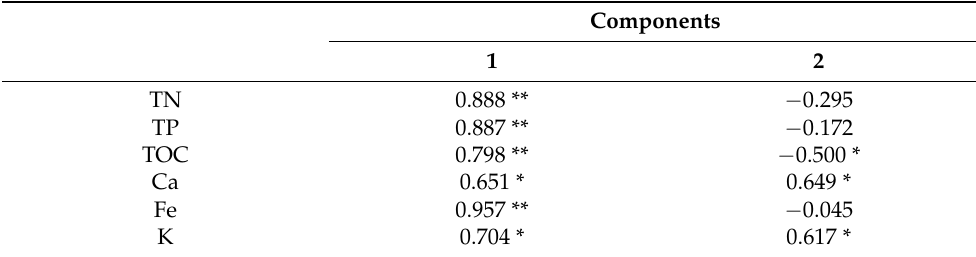
Table 8. Loading for PCA